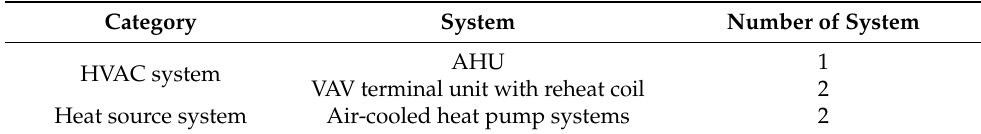
Table 1. System configuration.